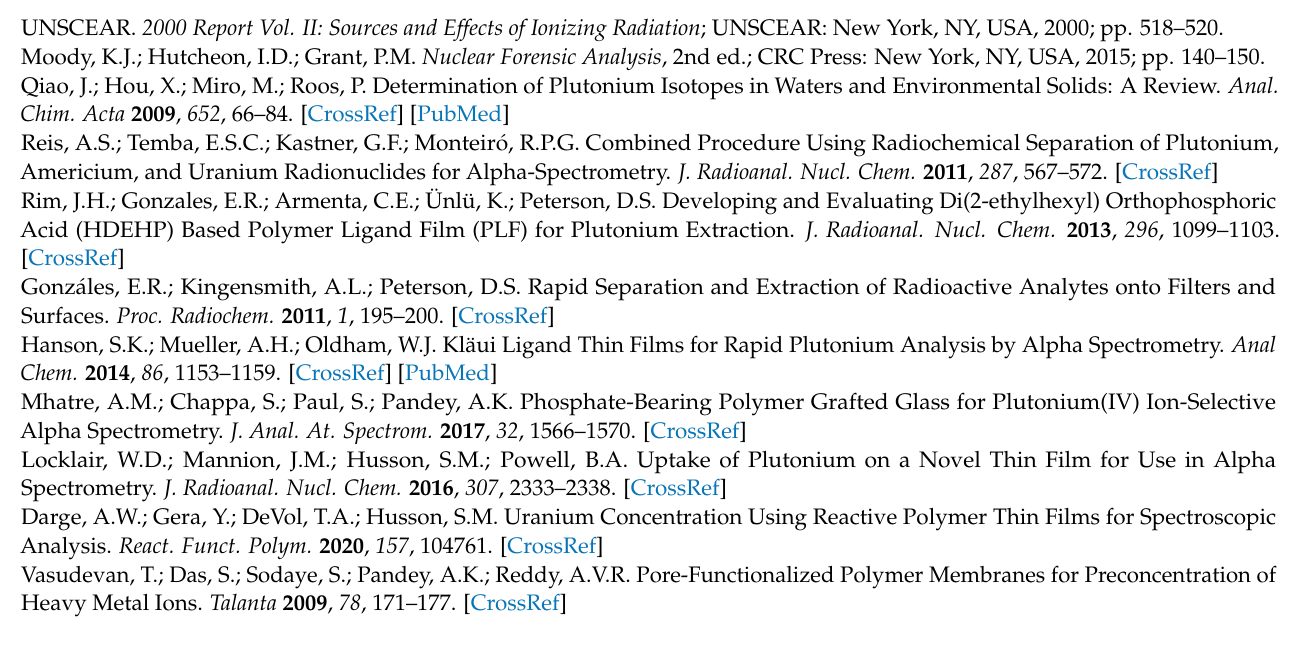
Table S2: Ion content of the synthetic seawater used in the direct filtration 238 Pu uptake studies; Table S3: Treatments for each batch of 10 wt% PVDF- g -EGMP membrane tested in the permeability study; Figure S1: Flux data for each 10 wt% PVDF- g -EGMP batch tested in the permeability study; Figure S2: Alpha spectrum of the 5 Bq 238 Pu smear efficiency calibration sample; Figure S3: Alpha spectra of the 0.5 mL samples taken for the 242 Pu uptake study; Figure S4: Sessile drop contact angle measurements of 100% PVDF membranes; Figure S5: Sessile drop contact angle measurements of PVDF membranes casted with 10% PVDF- g